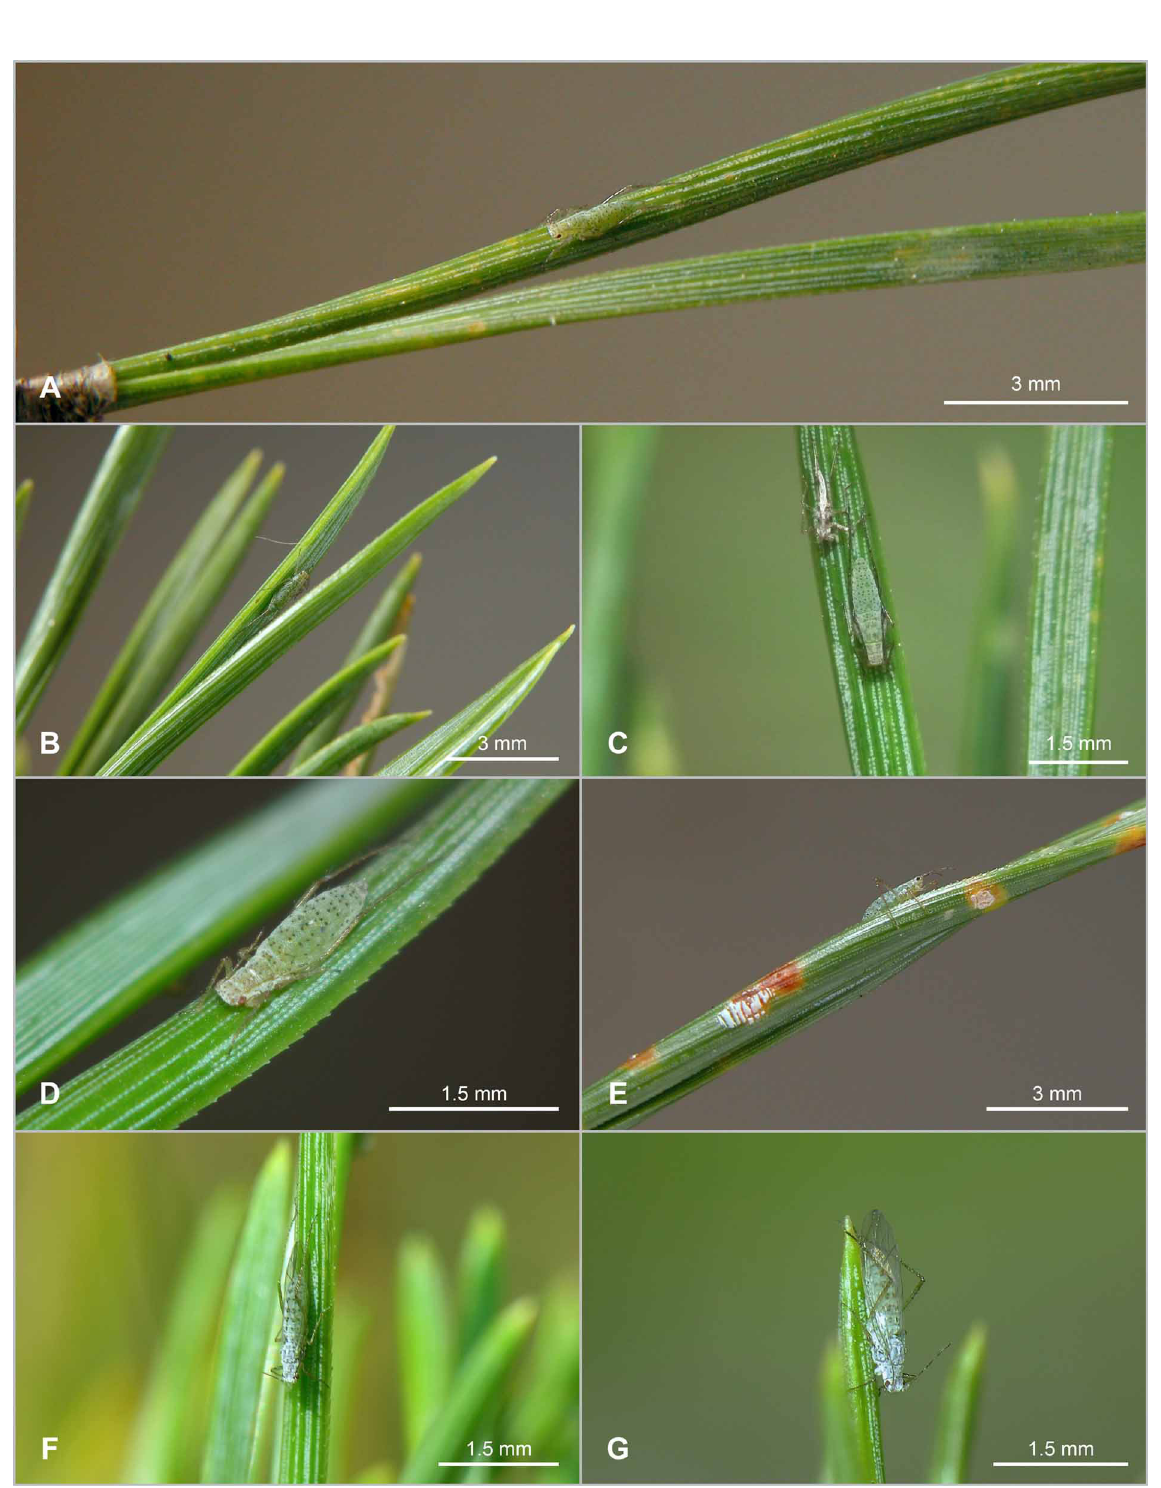
Fig. 82. Eulachnus agilis (Kaltenbach, 1843) on needles of Pinus sylvestris . A–E . Apterae. F–G .